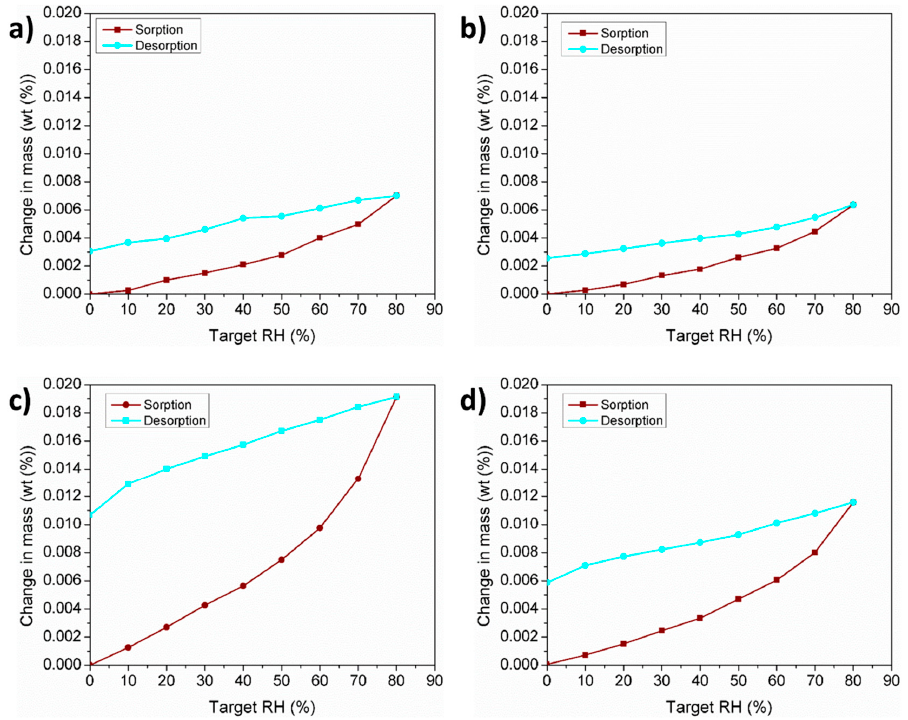
Figure 5. Dynamic vapor sorption (DVS) isotherms for ( a ) powder A, ( b ) powder B, ( c ) powder C, and (d) sieved powder C.